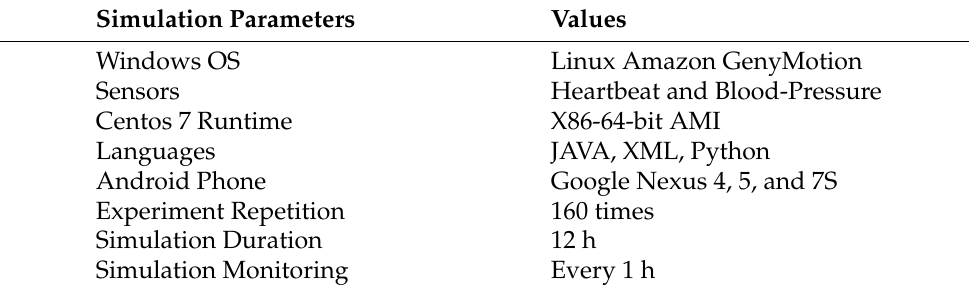
Table 4. Simulation